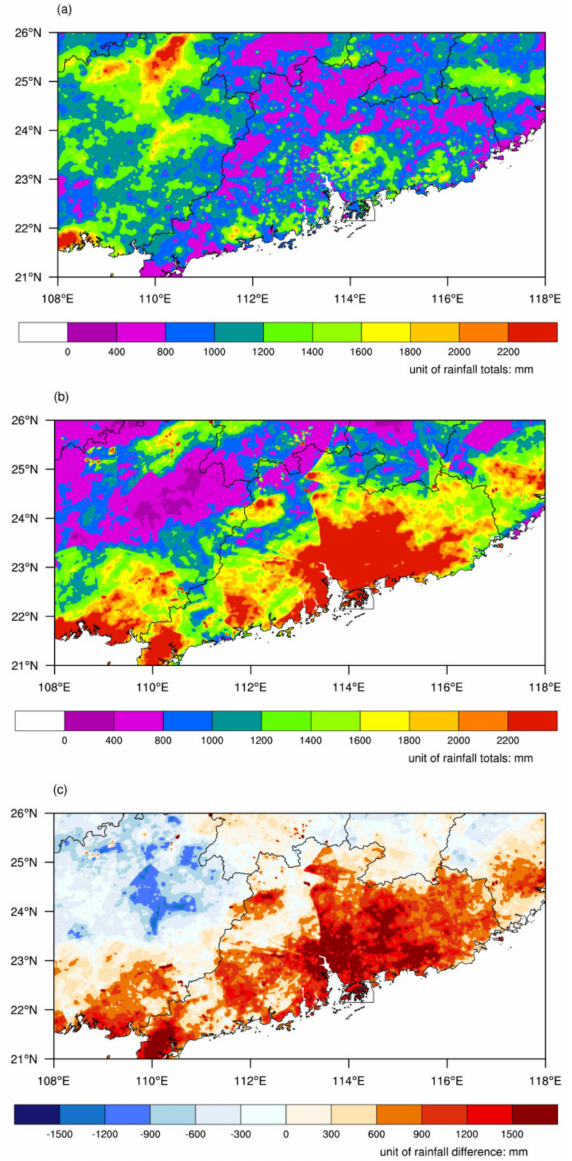
Figure 4. Distribution of summer rainfall totals (unit: mm) for the years 2019–2020. ( a ) Interpo- lated AWS rainfall totals, ( b ) radar QPE rainfall totals, ( c ) and difference between radar QPE and AWS